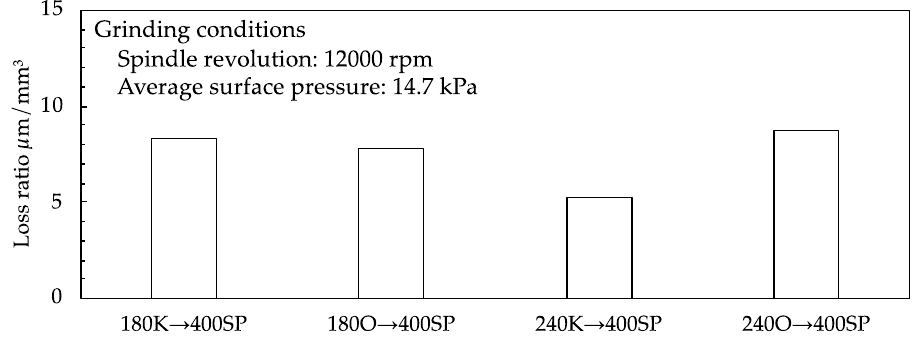
Figure 10. Loss ratios for rough and semi-finish grinding.